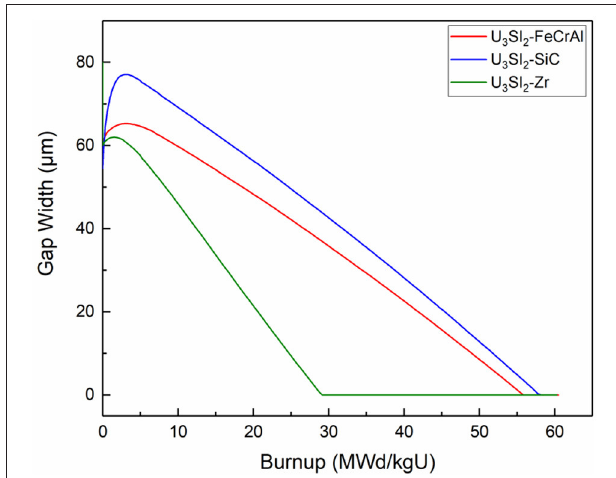
FIGURE 10 | Influence of cladding material on evolution of gap width (fuel: U 3 Si 2 ).